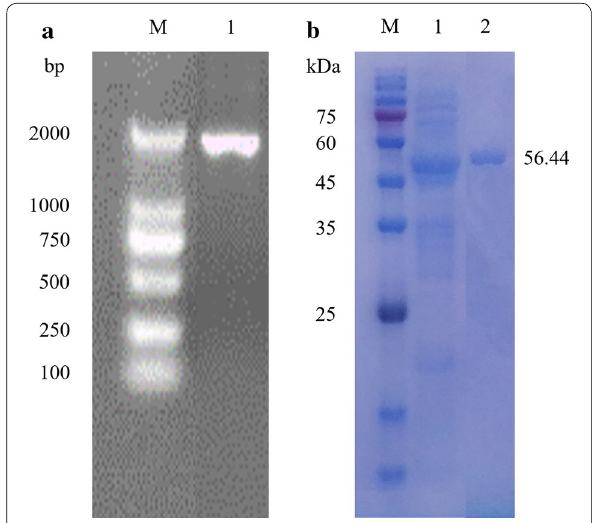
Fig. 1 Agarose gel electrophoresis and SDS-PAGE of purified Cel-5A. a PCR product of Cel-5A recombinant plasmid by universal primers T7/T7er. b Expression and purification of